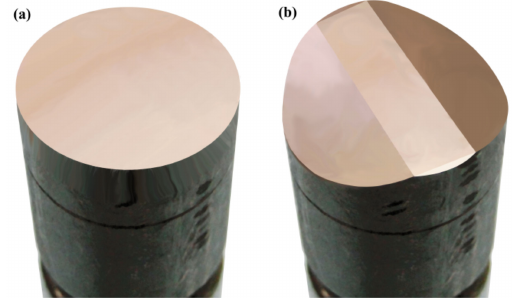
Figure 1. Electrodes: ( a ) the cylindrical planar electrode and ( b ) the rectangular terminal